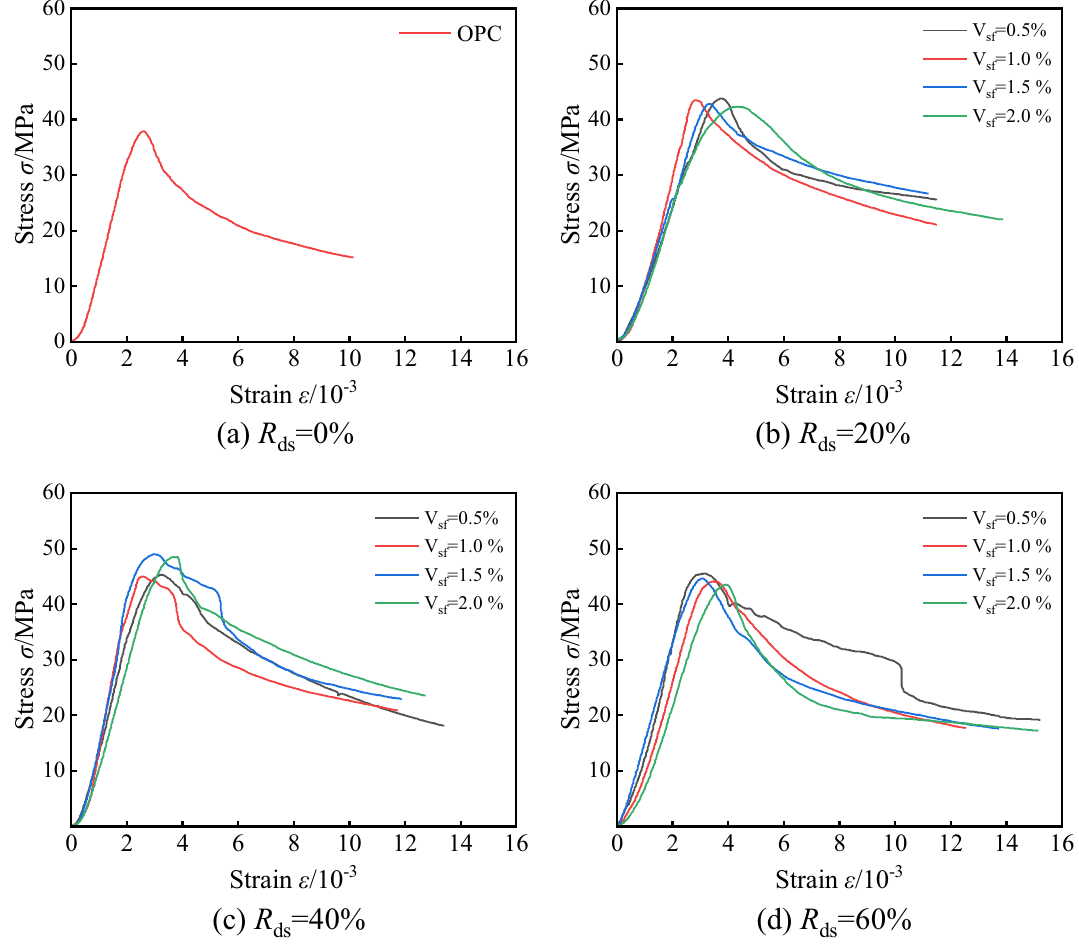
Figure 8. Stress–strain curves of SFDSC under uniaxial compression.